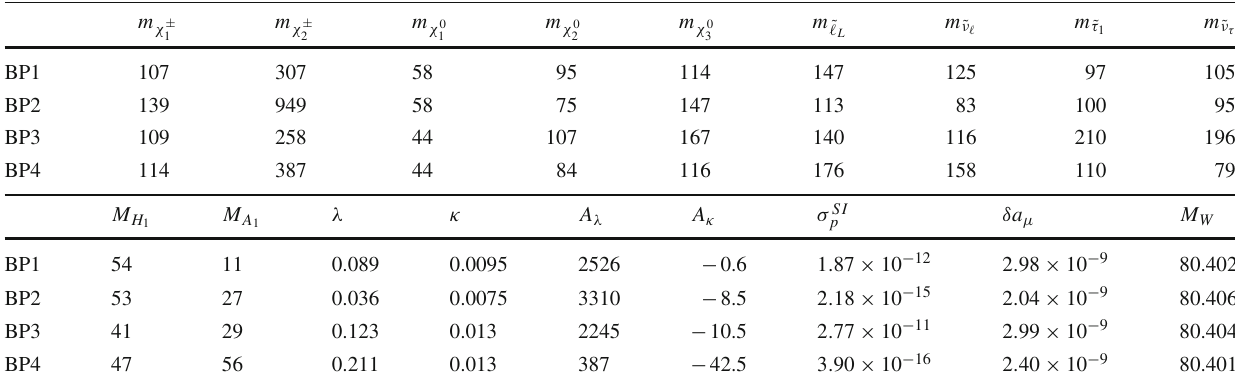
Table 2 Sparticle and mostly singlet-like Higgs boson masses (in GeV), NMSSM specific parameters, the spin-independent direct detection cross section of the LSP on protons (in pb), δ a μ and M W for four benchmark points. Leptons (cid:14) denote both electrons and muons m χ ± 1